Question: Condense the content of this figure into a single sentence.
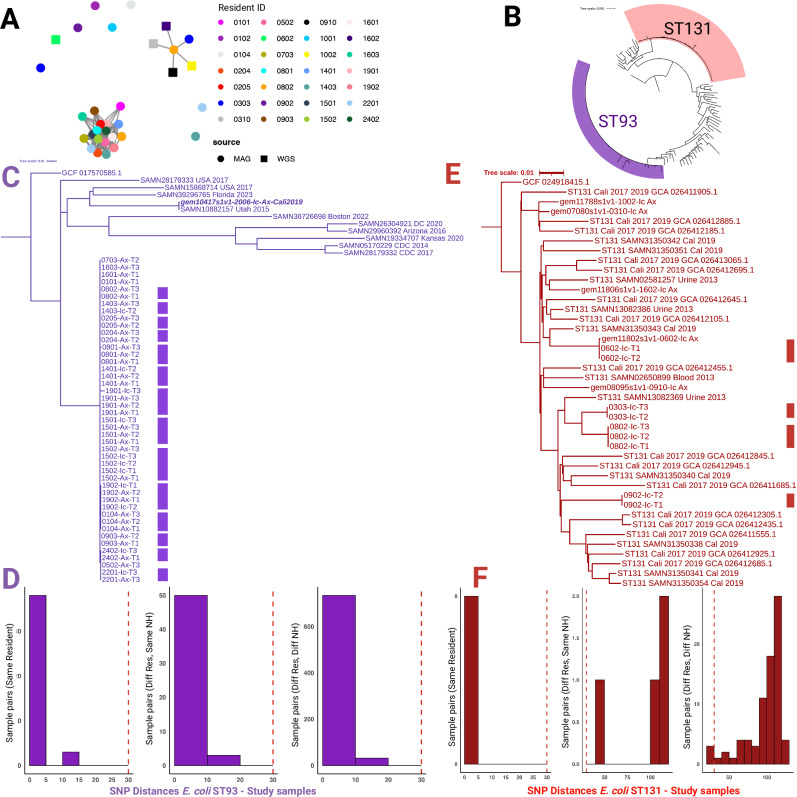
Answer: Comparative genomic analysis of E. coli strains from NH resident skin. A Network analysis of pairwise average nucleotide identity (ANI) among E. coli MAGs and isolate genomes from this study and the four isolate genomes from outside the cohort. Each node represents the highest-quality E. coli genome per resident, colored by resident. Circles denote MAGs and squares denote isolate whole genomes sequence (wgs). Edges connect genomes with ≥99.95% ANI, indicating high genetic relatedness. B Phylogenetic tree based on single-copy marker genes, including E. coli isolate genomes, MAGs from this study, and public reference genomes. Clades corresponding to E. coli ST131 and ST93 are highlighted in red and purple, respectively. C Phylogenetic tree of E. coli ST93 genomes from this study alongside representative references, inferred from core SNPs. The purple blocks along the tree mark samples from the same resident. gem10417s1v1_2006_Ic-Ax is the ESBL-producing E. coli ST93 obtained in another California NH in 2019. MAGs are labeled with residentID_bodysite_timepoint; D Histogram of pairwise core genome SNP distances among study-derived E. coli ST93 genomes. The red dashed line marks a 30-SNP threshold for strain-level relatedness. E Phylogenetic tree of E. coli ST131 genomes from study samples and public references, inferred from core SNPs. The red blocks along the tree mark samples from the same resident. F Histogram of pairwise core genome SNP distances between study-derived E. coli ST131 genomes and public E. coli ST131 references. The red dashed line denotes a 30-SNP threshold used to infer potential strain sharing. Abbreviations: Diff Subj different resident, Diff Fac different facilities/NHs. Figure panels were assembled using Biorender under publication license Segre, J. (2026) https://BioRender.com/s82td3a .